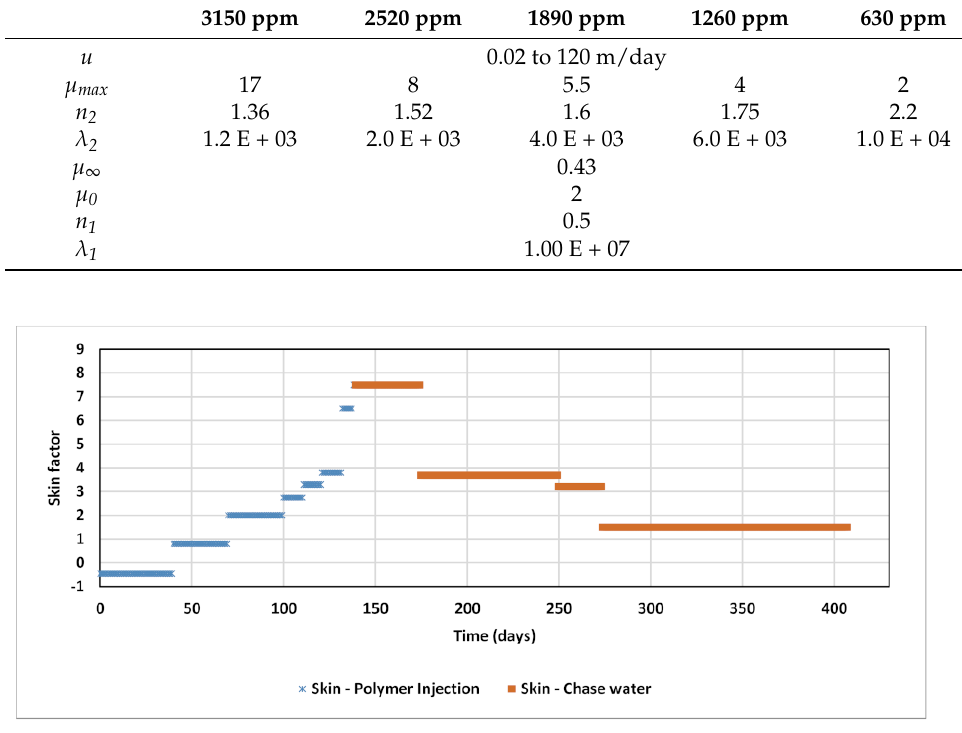
Figure 23. Skin factor applied along polymer injection and chase water in history